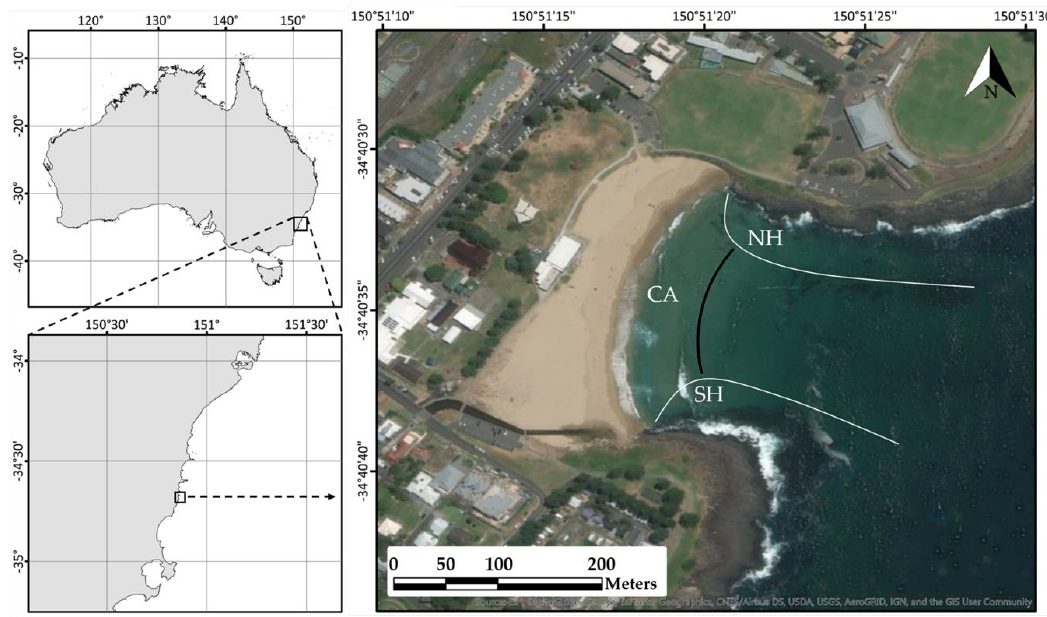
Figure 5. Geographical location of Kiama Surf Beach in Australia and map of the study area showing the three sub-habitats (NH: northern headland; CA: central area; SH: southern headland) and the sharp depth contour located approximately 30 m offshore during low tide and 50 m during high tide (black line).